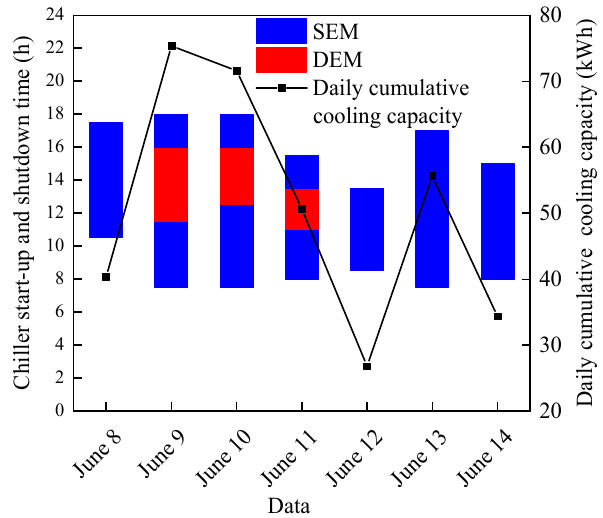
Figure 4. Daily single- and double-effect operation mode switching and daily cumulative cooling capacity of the system without auxiliary heater.